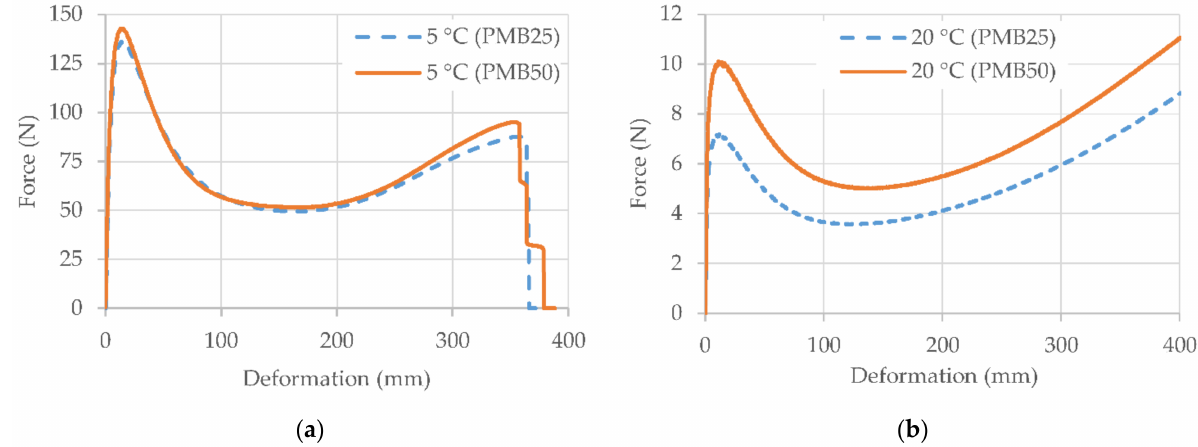
Figure 6. Force ductility results for the studied PMBs: ( a ) tests at 5 ◦ C; ( b ) tests at 20 ◦ C.